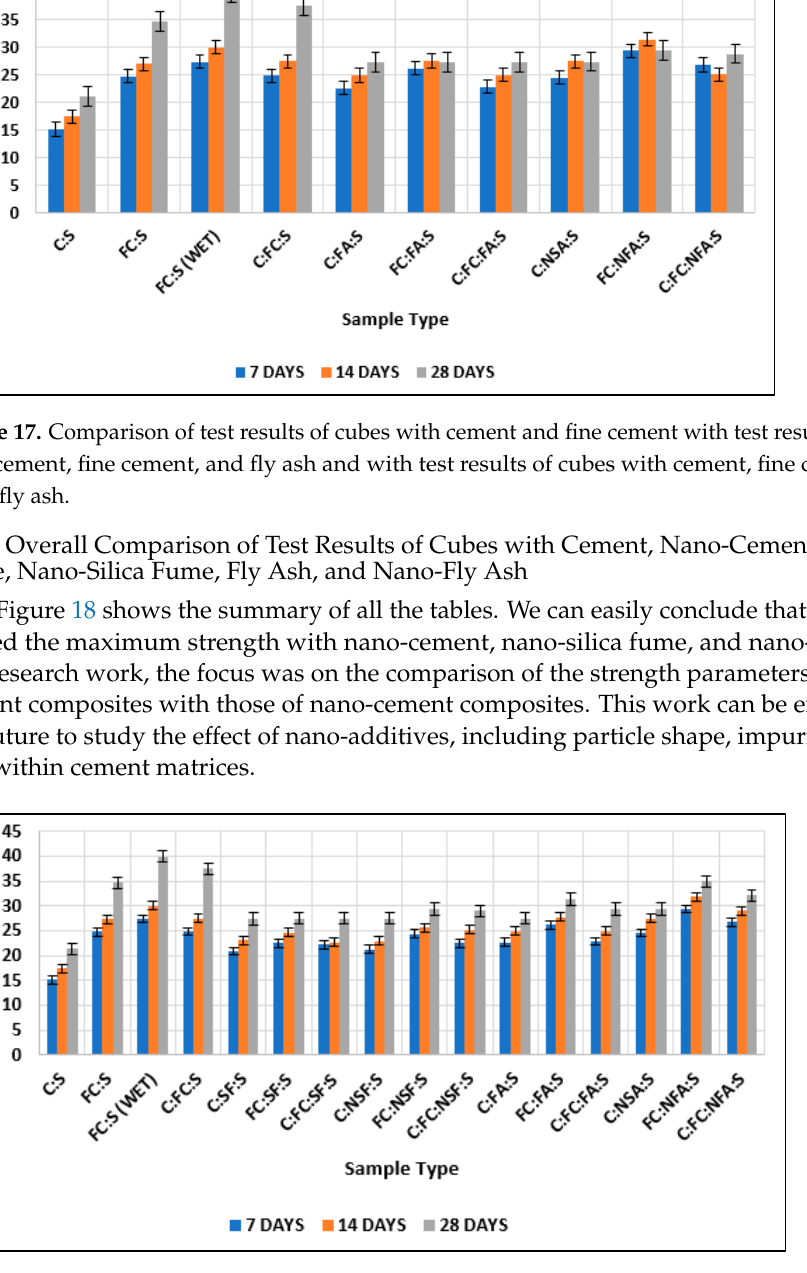
Figure 18. Comparison of test results of cubes with cement (C:S) and fine cement (FC:S) with the following: test results of cubes with cement (C:FC:S), fine cement, and silica fume; test results of cubes with cement, fine cement, and nano-silica fume; test results of cubes with cement, fine cement, and fly ash; test results of cubes with cement, fine cement, and nano-fly ash; and test results of cubes with